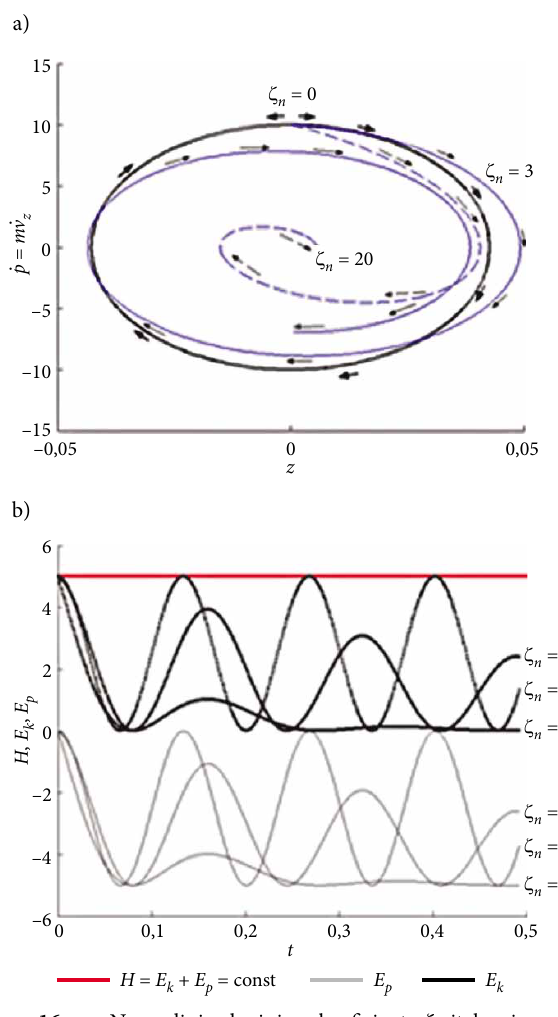
Fig. 16. The influence of normal dissipation coefficient (cid:93) n on the behaviour of the phase trajectory of the particle with one mechanical degree of freedom: a – phase trajectory of a particle, when (cid:93) = 0, (cid:93) = 3, (cid:93) = 20; b – Hamiltonian n n n particles and changes in the kinetic and potential energy of the particle under normal coefficients of dissipation